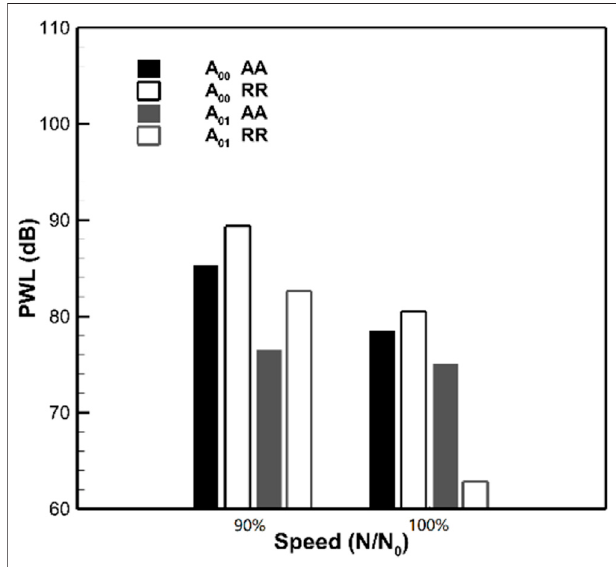
FIGURE 16 | Comparison of results for radial modes n = 0 and n =